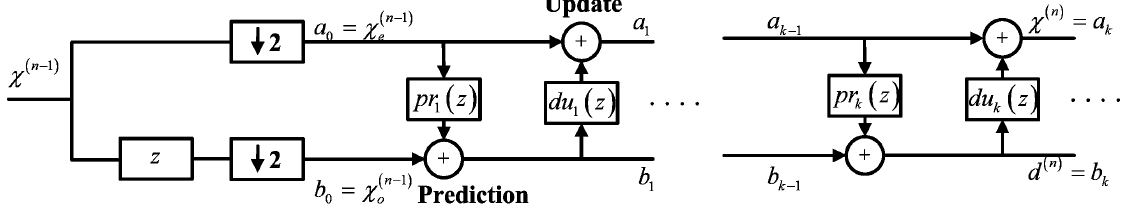
Figure 2. The structure of the lifting scheme in